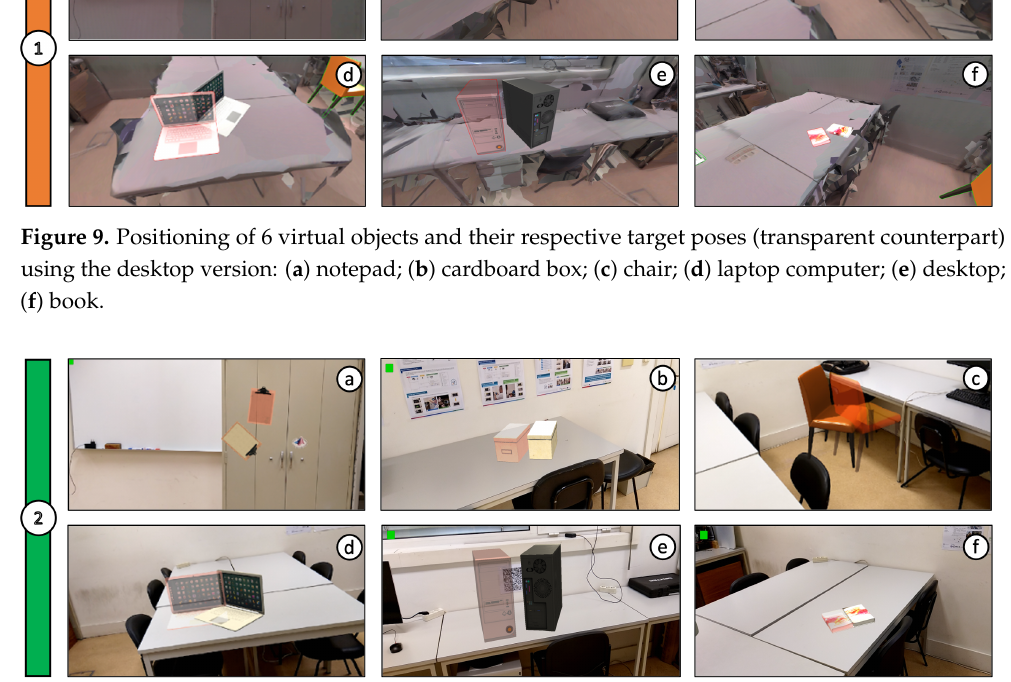
Figure 10. Positioning of 6 virtual objects and their respective target poses (transparent counterpart) through the mobile version: ( a ) notepad; ( b ) cardboard box; ( c ) chair; ( d ) laptop computer; ( e ) desktop; ( f )